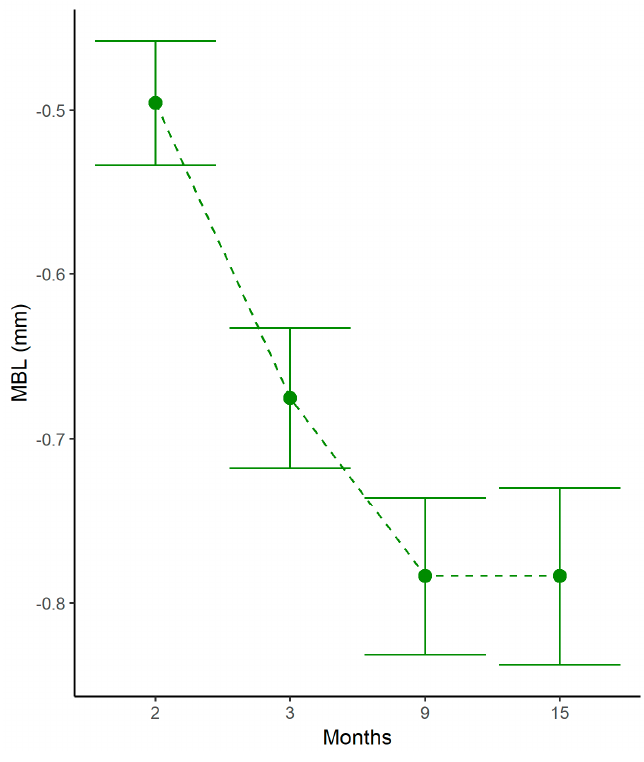
Figure 3. Marginal bone variations at different time points. MBL: marginal bone loss.